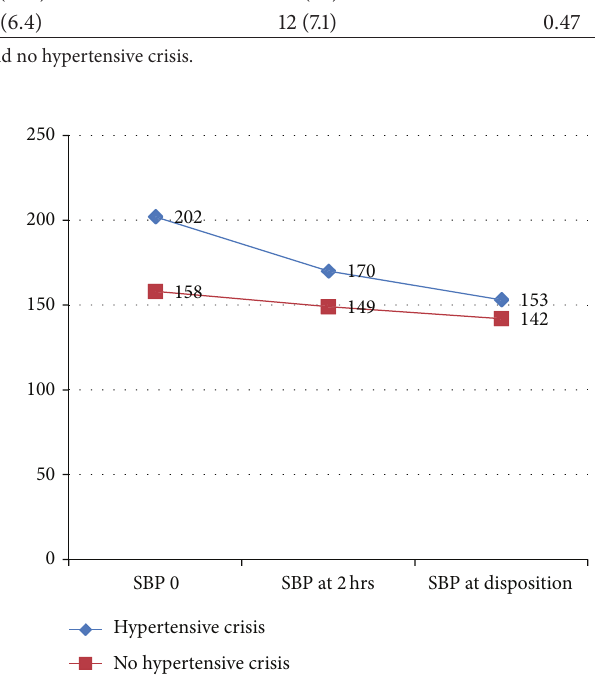
Figure 1: Trend of systolic blood pressure in ER.